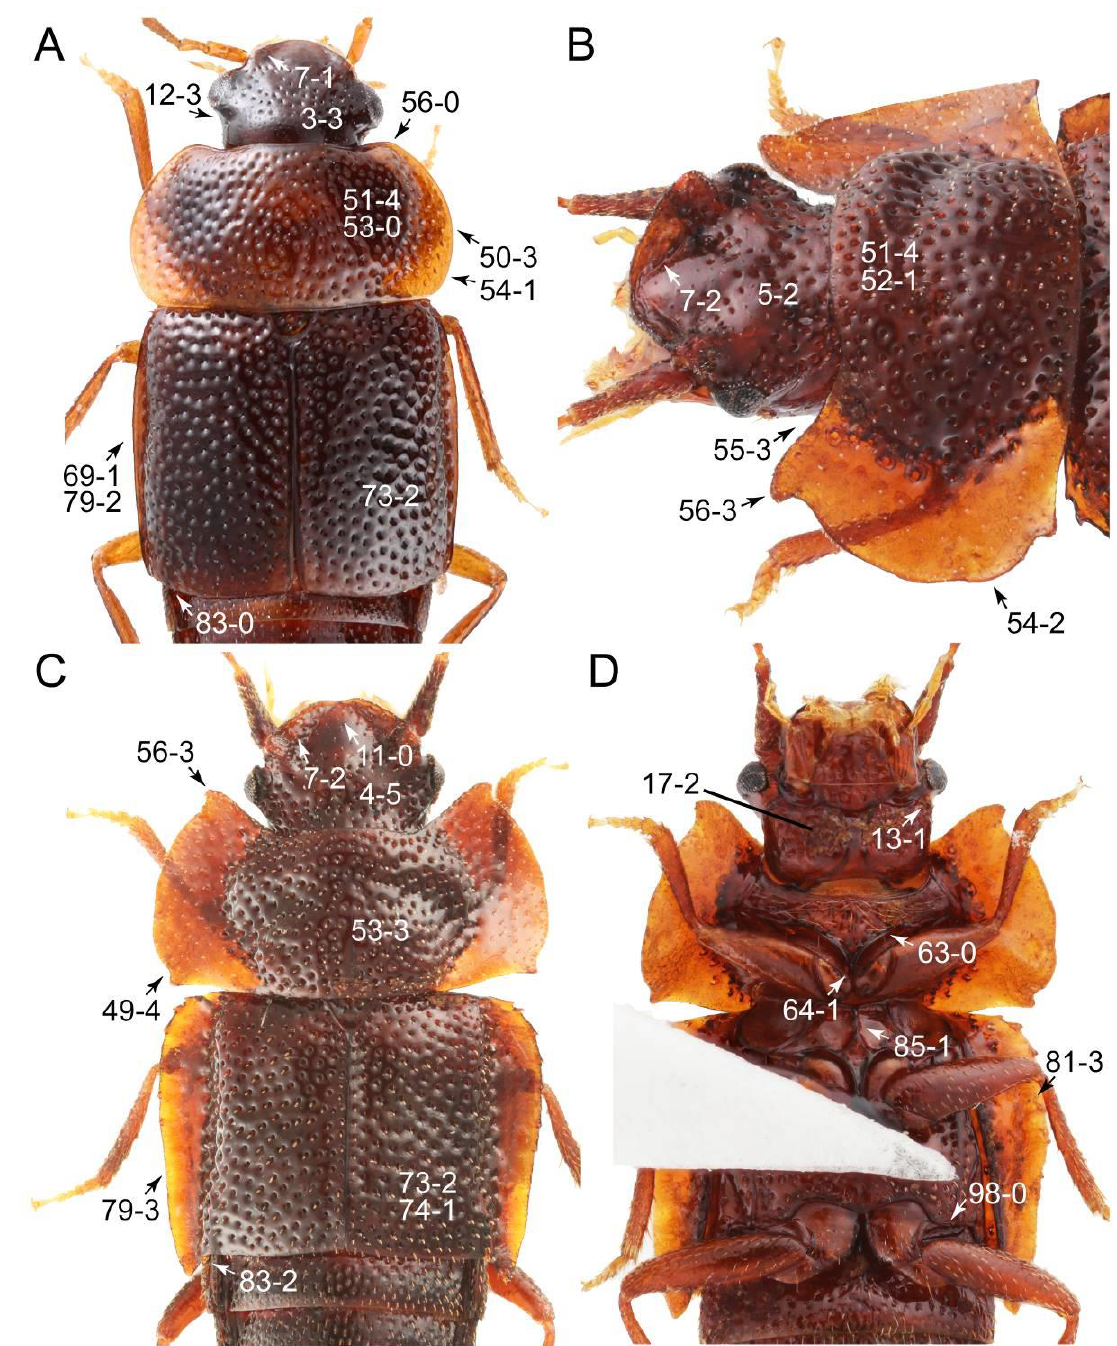
Figure 58. Photographs of body parts of Tachinusini: members of the former Megarthropsini, enlarged. ( A ) forebody of Lacvietina takashii , dorsal view. ( B ) head and pronotum of Nepaliodes solangelae , dorsolateral view. ( C ) forebody of Nepaliodes solangelae , dorsal view. ( D ) forebody of Nepaliodes solangelae , ventral view. Characters and character states (format X-X) are indicated on each